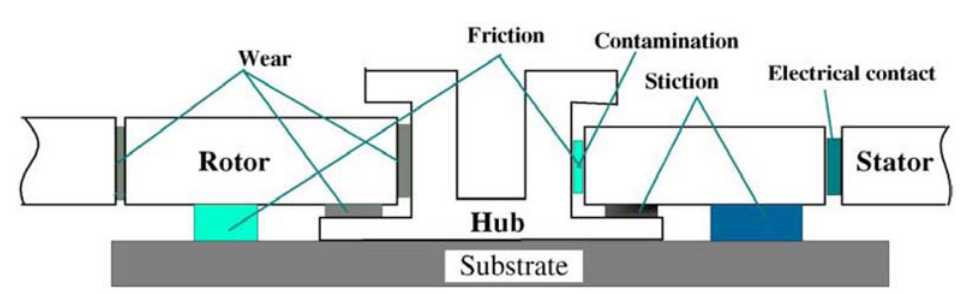
Figure 11. Tribology issues during micromotor operation